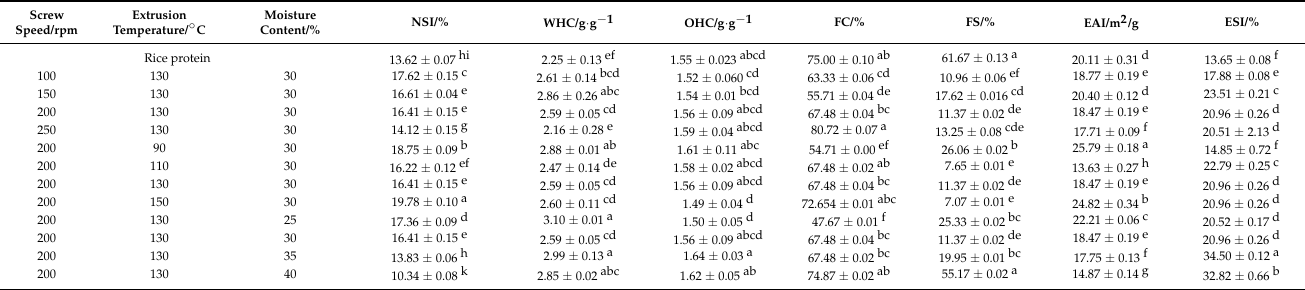
Table 2. Functional properties of the TRP with different extrusion